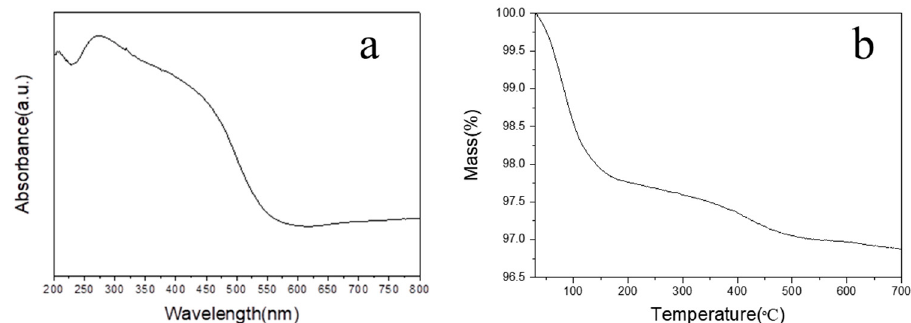
Figure 4. Di ff use reflectance ultraviolet–visible spectra ( a ) and thermal gravimetric curves ( b ) for the Figure 4. Diffuse reflectance u ltraviolet–visible spectra ( a ) and thermal gravimetric curves ( b ) for Cs 2 H 4 PV 3 MoW 8 O 40 the Cs 2 H 4 PV 3 MoW 8 O 40 catalyst.